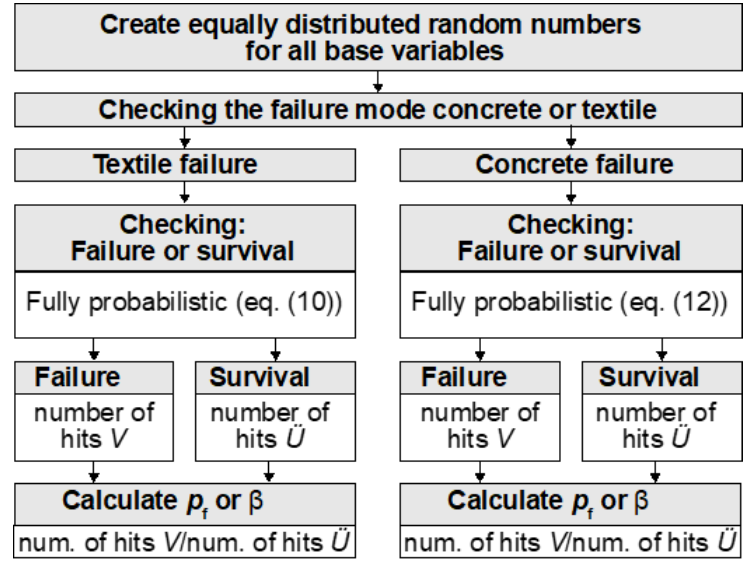
Figure 6. Flowchart for the calculation of the failure probability according to the Monte Carlo method.